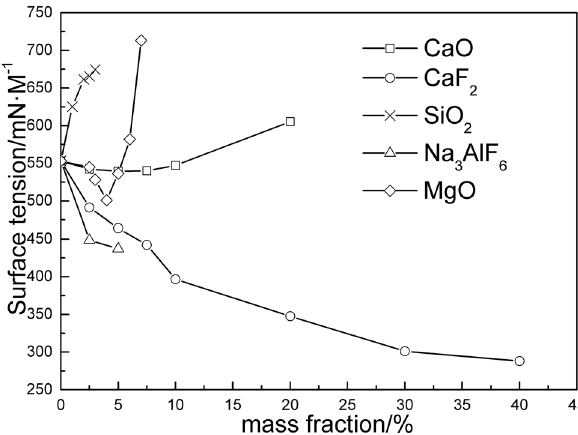
Figure 7: E ff ect of di ff erent additives on the surface tension of slags at 1,923 K ( 1,650°C )